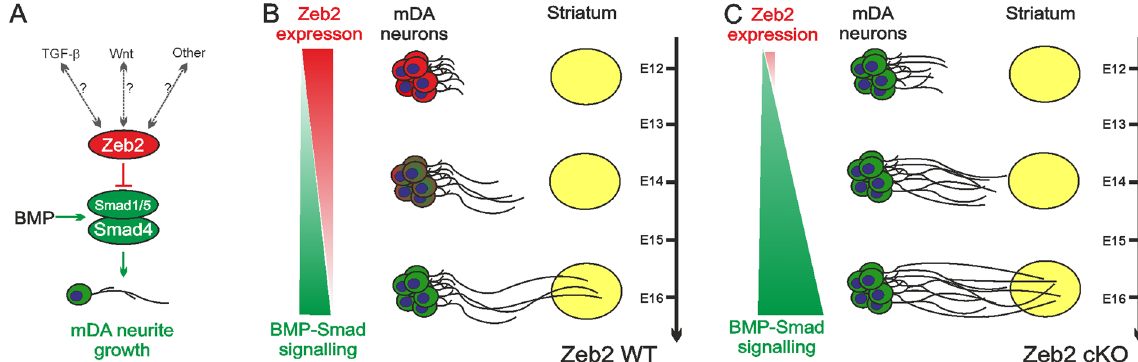
Figure 5. Zeb2 cell-autonomously represses Smad signalling to limit mDA neuronal growth and target innervation. ( A ) Schema showing the proposed role for Zeb2 as a cell-autonomous regulator of BMP-Smad1/5 signalling, which promotes neurite growth in mDA neurons. In future work it will be interesting to disentangle any potential cross-talk between Zeb2 and other molecular pathways that promote neurite growth in mDA neurons, including TGF- β s and Wnts. ( B ) Proposed model of the contribution of Zeb2 to the embryonic development of mDA target innervation based on current data. During peak mDA neurogenesis at ~E12 in mice, high levels of Zeb2 repress BMP-Smad signalling to limit mDA neurite growth. As mDA neurons extend axons and innervate the striatum from E12-E16, a reduction in Zeb2 levels leads to an increase in BMP-Smad- dependent transcriptional activity which promotes neurite growth in mDA neurons. ( C ) Knockdown of Zeb2 removes a cell-autonomous inhibitory mechanism that results in excessive mDA neurite growth through BMPR1b-Smad-dependent signalling, which causes hyperinnervation of the striatum in vivo . Whether this mDA hyperinnervation persists throughout the lifespan is an important topic for future investigation. In summary, these data provide new evidence for a Zeb2-controlled signalling mechanism that operates in mDA neurons to regulate axon growth and target innervation during embryonic CNS